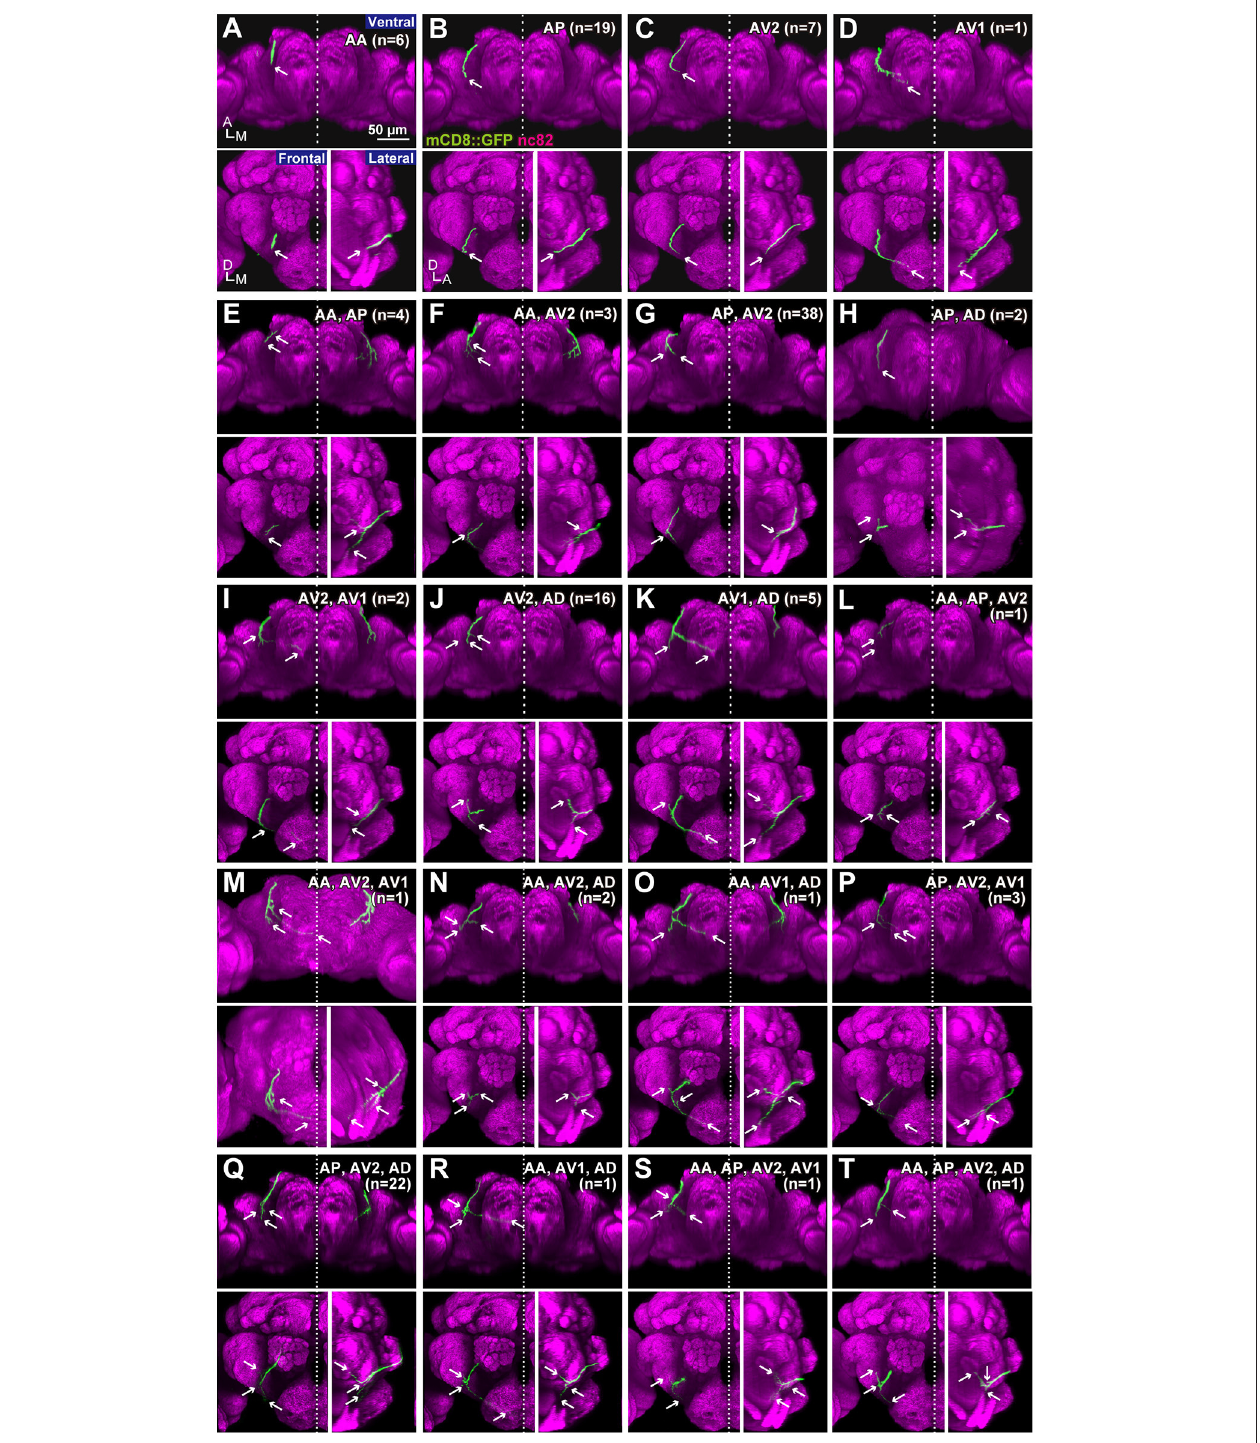
FIGURE 3 | Projection patterns of JO-A neurons. Ventral, frontal, and lateral views of the brain that visualize single JO-A neurons are shown. The projection target of each neuron is shown at the upper-right of each panel. Arrows denote the projection target. Signals of cells that were not relevant to JO-A neurons were manually erased from the original images for clarity. Green and magenta signals show the neurons and neuropils labeled with mCD8::GFP and nc82 antibody, respectively. All but (H,M) were registered to a template brain (A–G , I–L , N–T) . A, anterior; D, dorsal; M, medial.